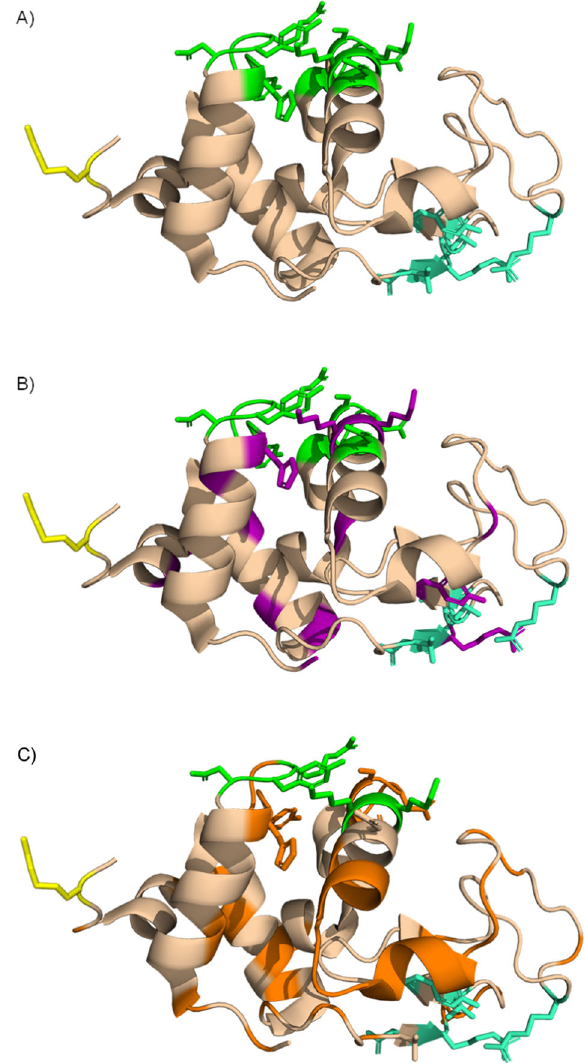
Fig.5|CartoonrepresentationHEWL3Dstructures.A Cartoonrepresentationof HEWL showing the three different crystallographic binding sites of Cu II WD (B1- [green]: His15, Gly16, Asn19, Tyr20, Arg21, Asn93, Lys96, and Lys97; B2-[green- cyan]:Asn44,Arg45,Asn46,Thr47;B3-[yellow]:Arg128,andthestrongestMS-POM/ HEWL interactions identi fi ed previously by molecular dynamics simulations 36,80 . B Cartoon representation of the main residues with side chain modi fi cations (magenta) overlapped with Cu II WD/HEWL binding sites in the HEWL structure in the presenceof Cu II WD/Asc. C Cartoon representation of the main regions thatare oxidatively cleaved (orange) overlapped with Cu II WD/HEWL binding